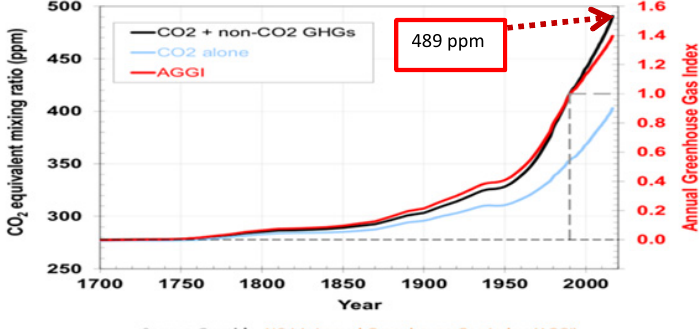
Fig. 1: GHGs concentrations of the atmosphere in 2016